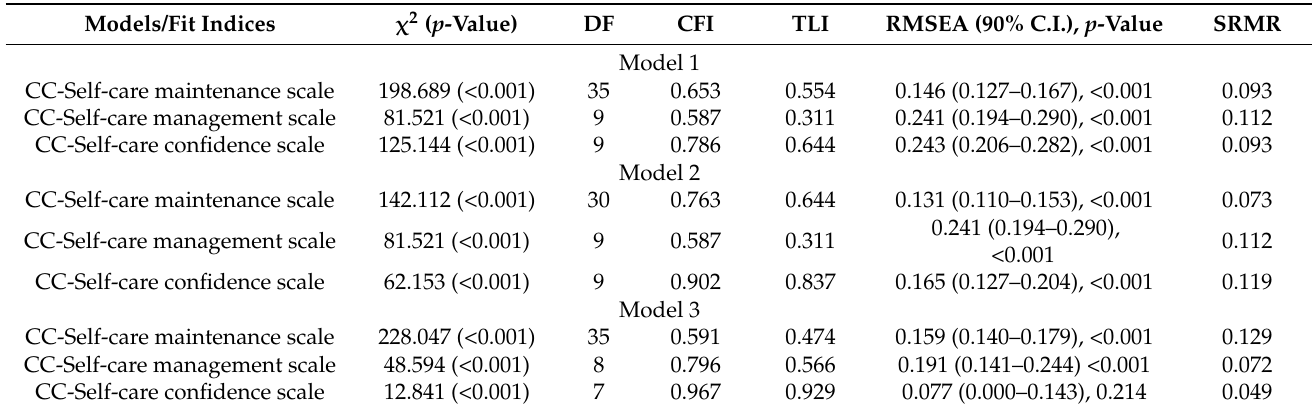
Table 3. Goodness of fit indices for the previous CC-SCHFI factor models tested via